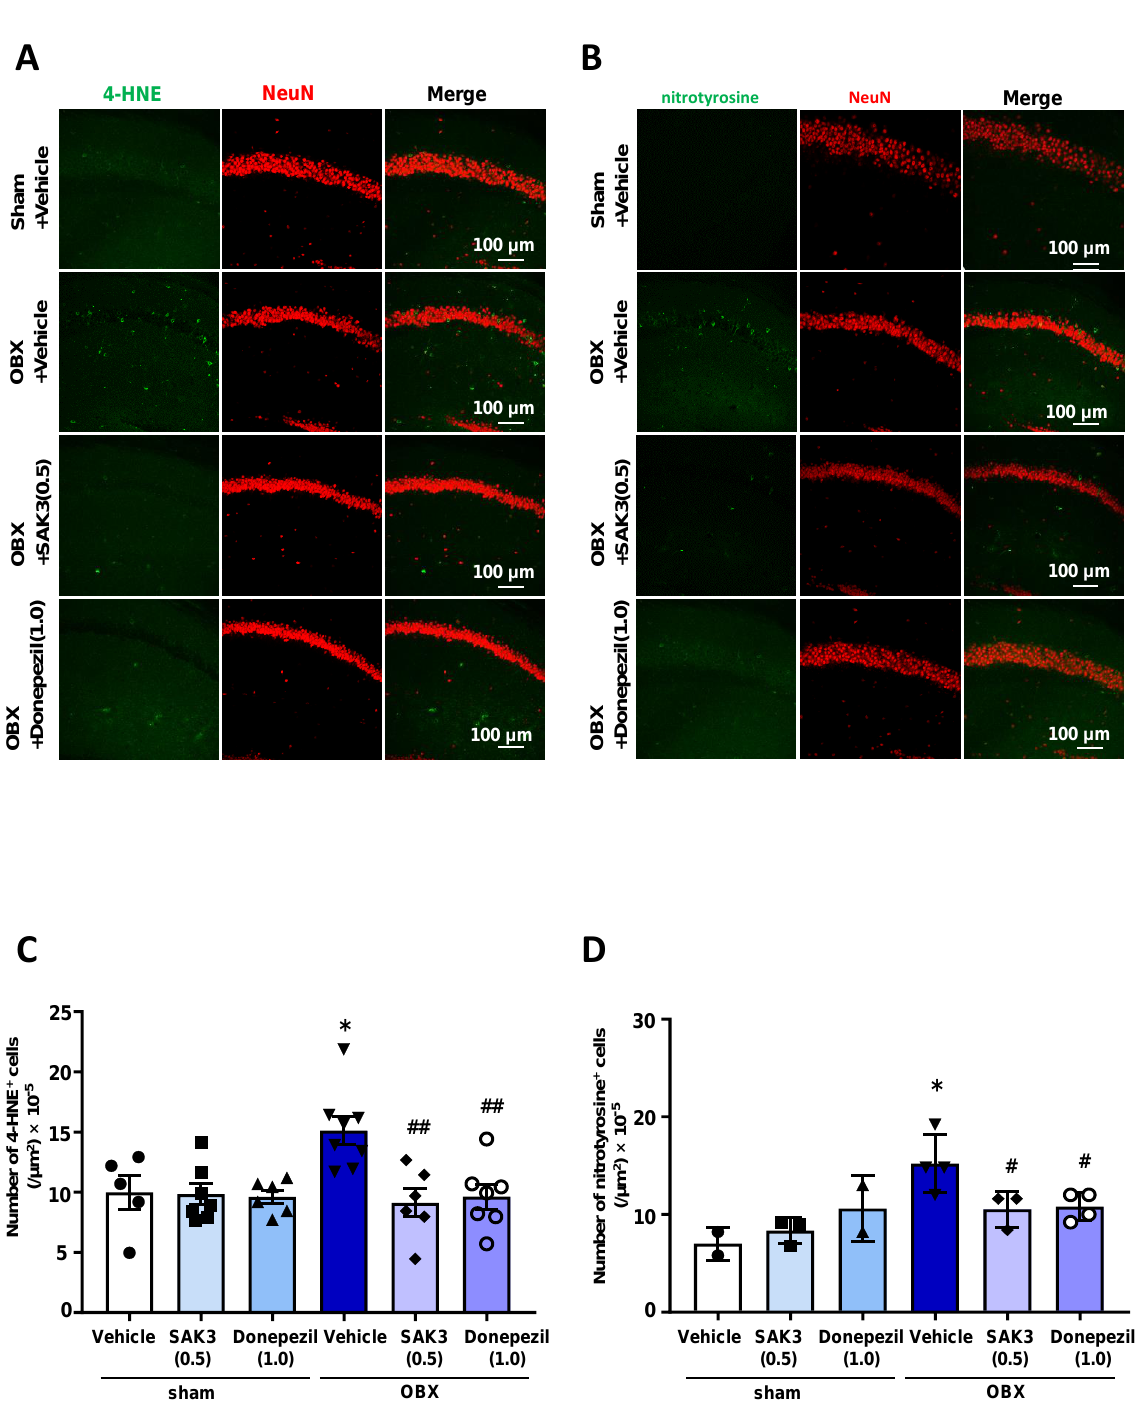
Figure 3. Immunohistochemistry reveals that SAK3 and donepezil inhibited OBX surgery-induced oxidative damage: Representative images of fluorescence immunostaining with anti-4-HNE antibody ( A ) or anti-nitrotyrosine antibody ( B ) in the hippocampal CA1 regions. Scale bars: 100 µ m; Quantitative analyses of the number of 4-HNE-positive cells ( C ) or nitrotyrosine-positive cells ( D ) in the CA1 (n = 5–8 per group). Error bars represent standard error of mean. The scattered solid circles, squares, regular triangles, inverted triangles, rhombuses and hollow circles inside the histograms were plotted using the real values to show the results clearly. * p < 0.05 vs. vehicle-treated sham mice; ## p < 0.01 vs. vehicle-treated OBX mice; # p < 0.05 vs. vehicle-treated OBX